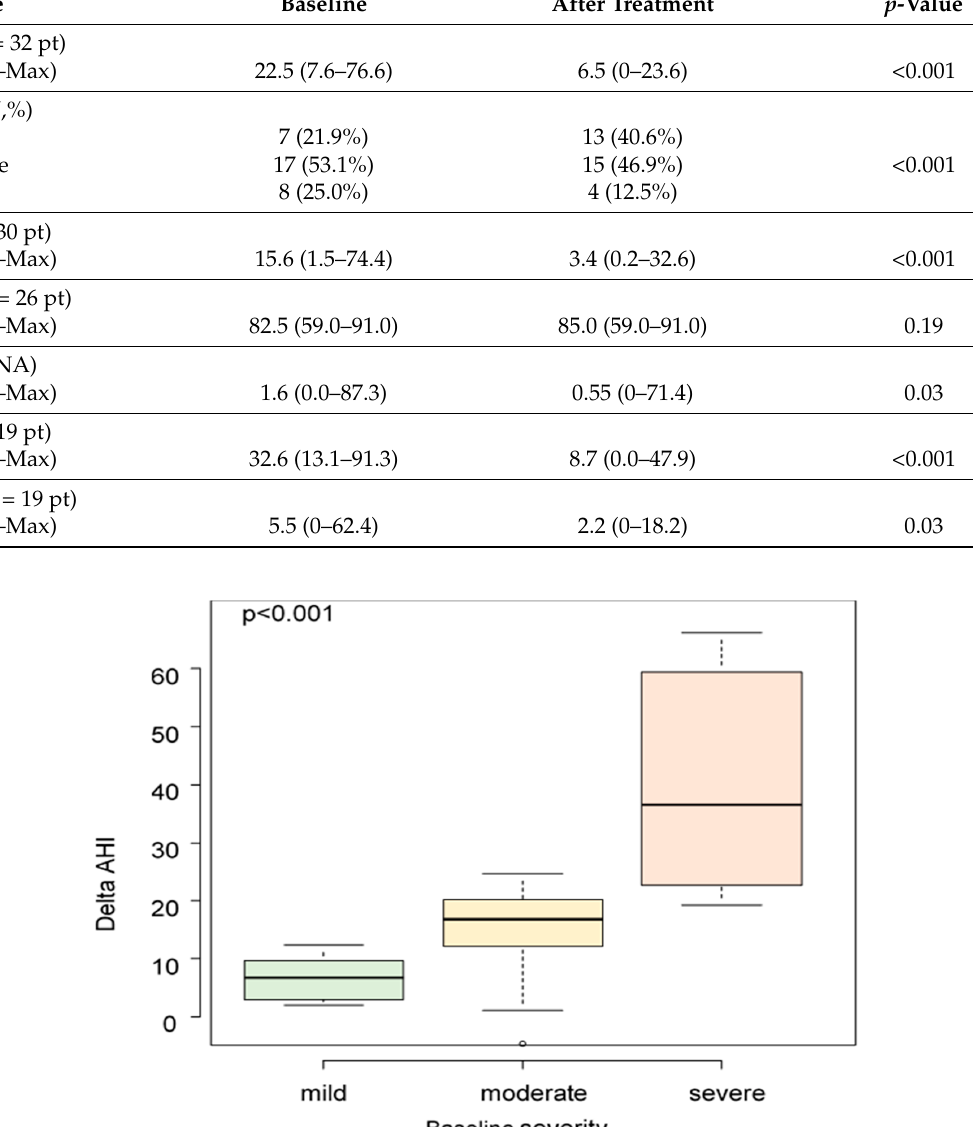
Table 4. Polygraphic variable before and after treatment.